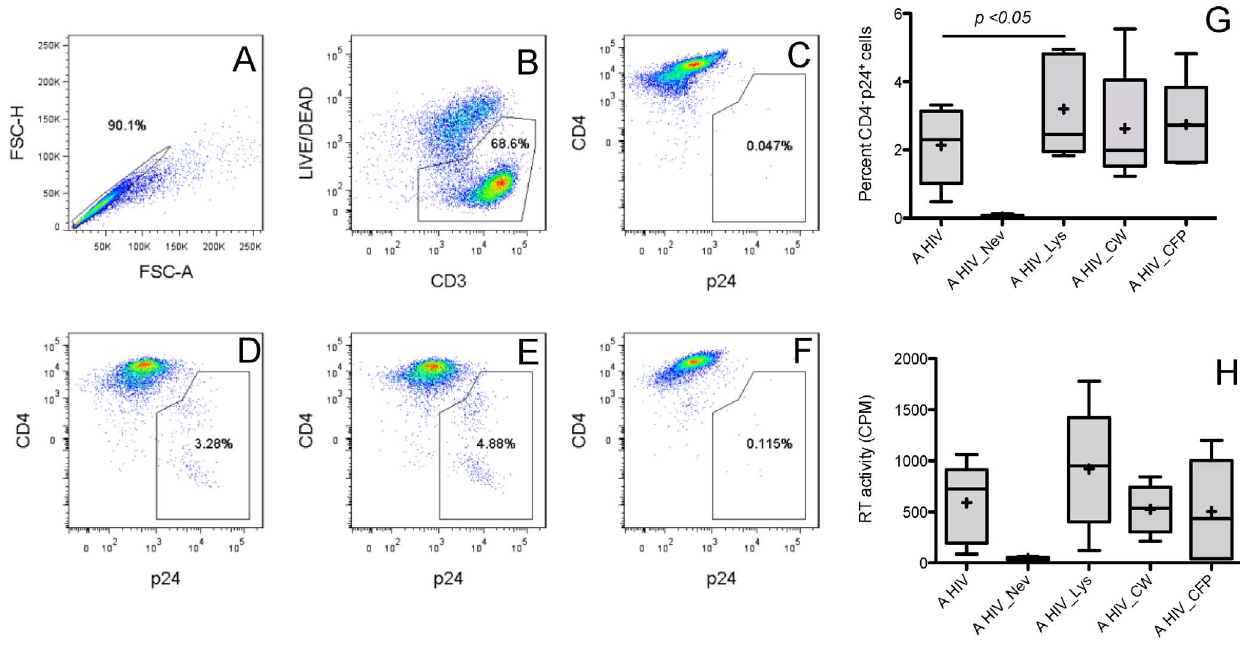
Figure 1. Effect of MTB subcellular fractions on HIV-1 infection in CD4 + T cells. (A–C) Gating strategy for detection of HIV-1 infected T cells by FACS. CD4 + T cells were labeled with live/dead violet, a -CD4 (surface), a -CD3 (surface) and a -p24 (intracellular). Singlet and live cell/CD3 + gates were subsequently applied before analyzing CD4 and p24 expression. In resting cells (C), HIV-1 is not detected as demonstrated by absence of CD4 2 p24 + events. (D–F) Detection of intracellular HIV-1 by FACS in activated T cells. CD4 + T cells were activated with a -CD3, a -CD28, anti-CD49d and IL-2 and with either (D) medium alone or (E) MTB lysate overnight. Cells were then infected with HIV-1 and labeled, acquired and gated as described. (F) Cells were treated with nevirapine after infection as a negative control. (G–H) Cumulative data for percent of HIV-1 infected T cells (CD4 2 p24 + cells; G) and viral load in culture supernatants (RT assay; H) from five independent experiments with different donors. T cells were infected with HIV-1 (MOI 0.01 to 0.1) after activation with a -CD3, a -CD28/CD49d and IL-2 in medium alone (AHIV) or in medium containing MTB lysate (AHIV_Lys), MTB cell wall (AHIV_CW) or MTB culture filtrate proteins (AHIV_CFP). Cells treated with nevirapine after infection served as negative control (AHIV_Nev). Shown are means (crosses), medians (horizontal lines inside the boxes), first and third quartiles (lower and upper lines of the boxes) and the maximum and minimum values (upper and lower